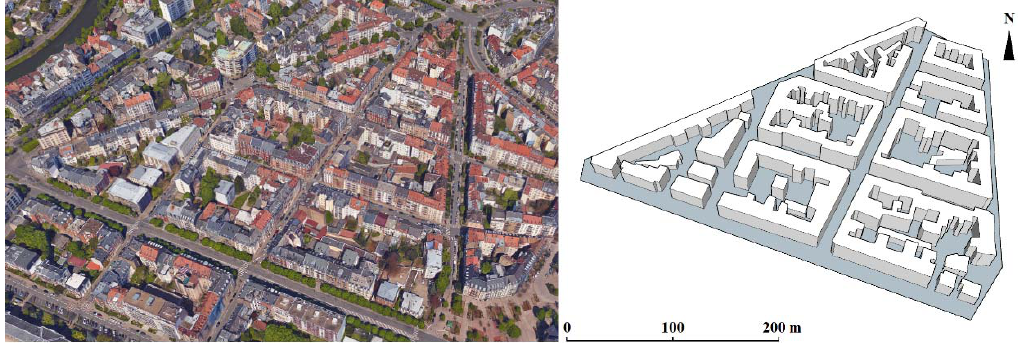
Figure 11. Google maps image and 3D geometry of the scene extracted from the BD Topo to extend the validation tests.